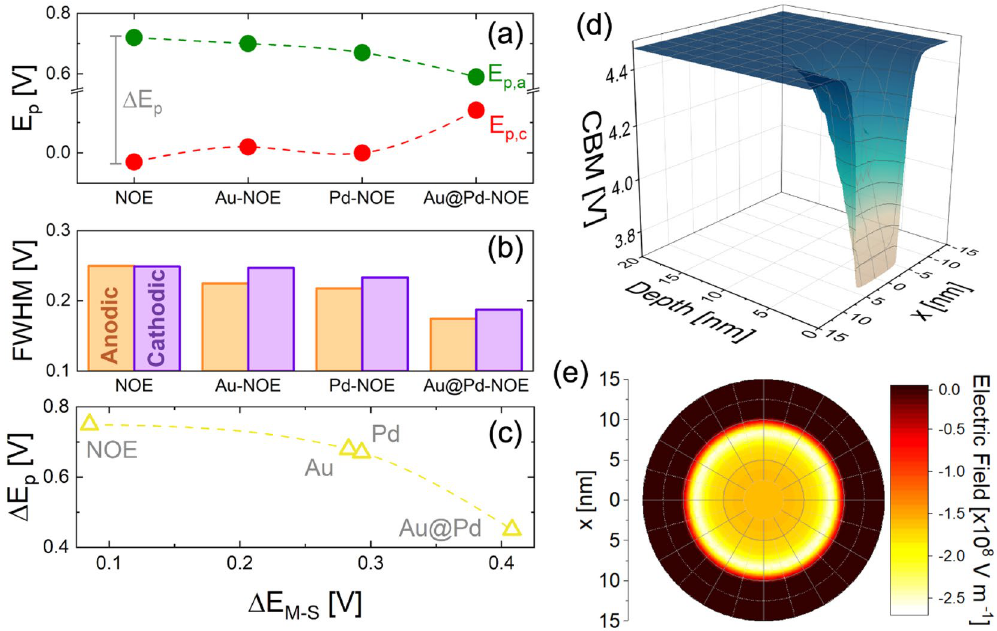
Figure 4. Variation of ( a ) E p , a and E p , c as a function of metal NP decoration (the peak separation between the two peaks positions in labelled as (cid:31) E p ), ( b ) FWHM of the anodic and cathodic peaks; ( c ) relation between (cid:31) E p and (cid:31) E M − S ; COMSOL simulations of ( e ) conduction band minimum (CBM) of Au@Pd-NOE sample, and ( f ) electric field map under a circular Au@Pd